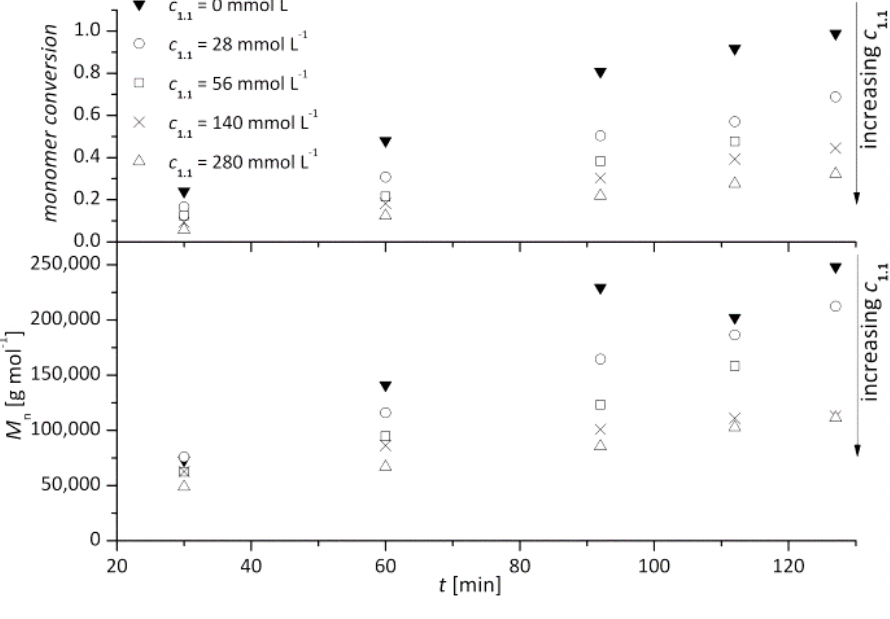
, and the monomer n 3 and 1.1 mmol·L − 1 6